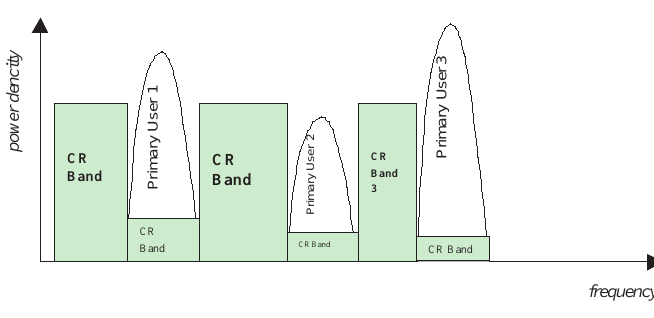
Figure 47. Soft decision cognitive